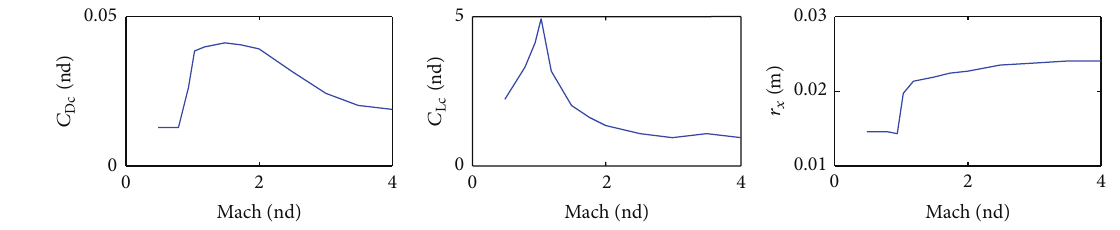
Figure 6: Canard aerodynamic parameters versus Mach number.